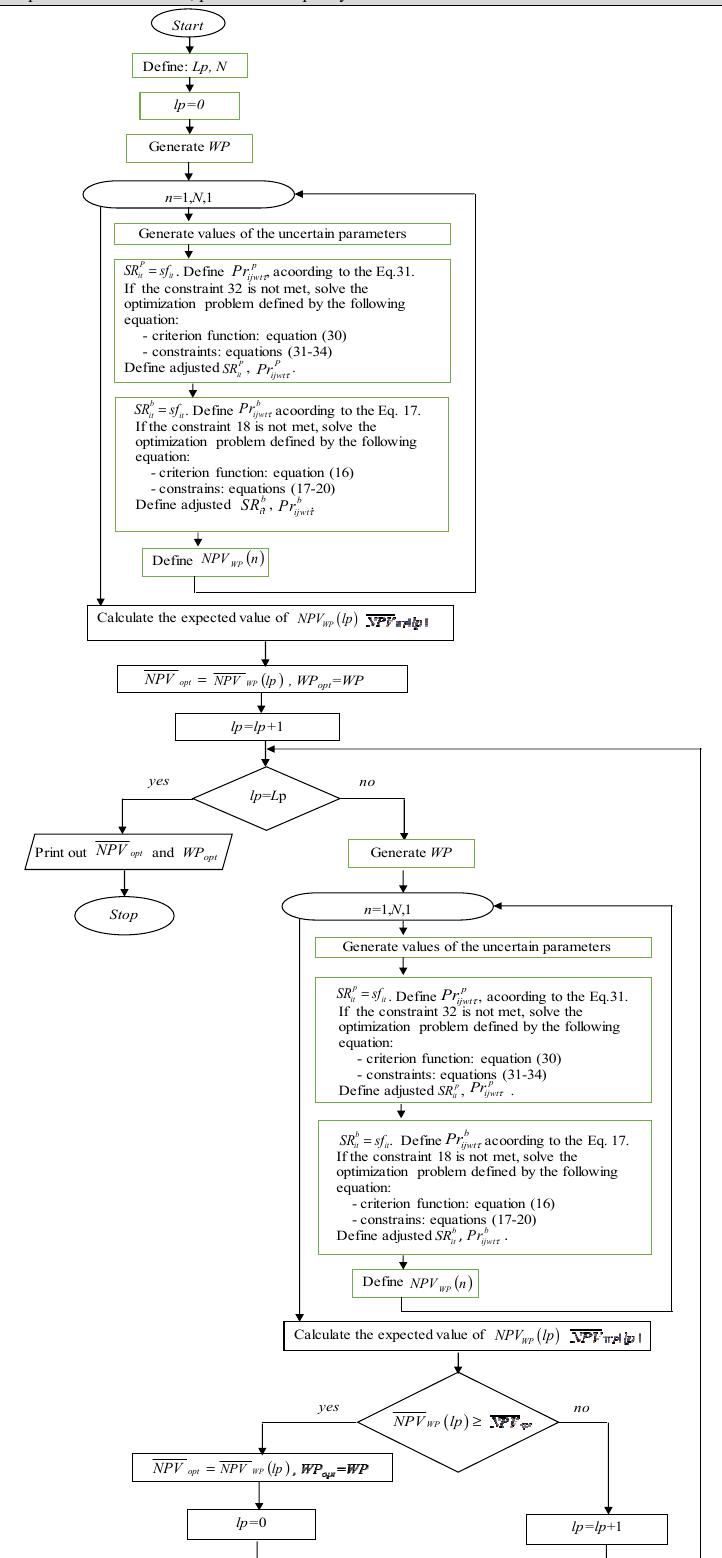
Fig. 3. The algorithm for selecting a static optimal investment